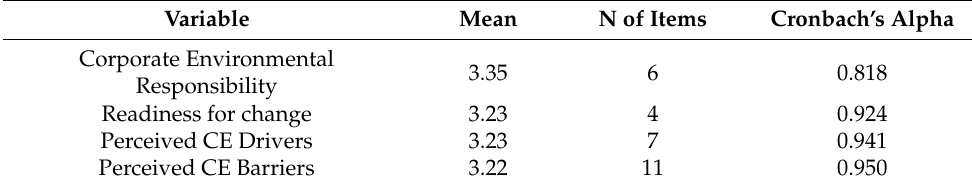
Table 1. Reliability Analysis Results.